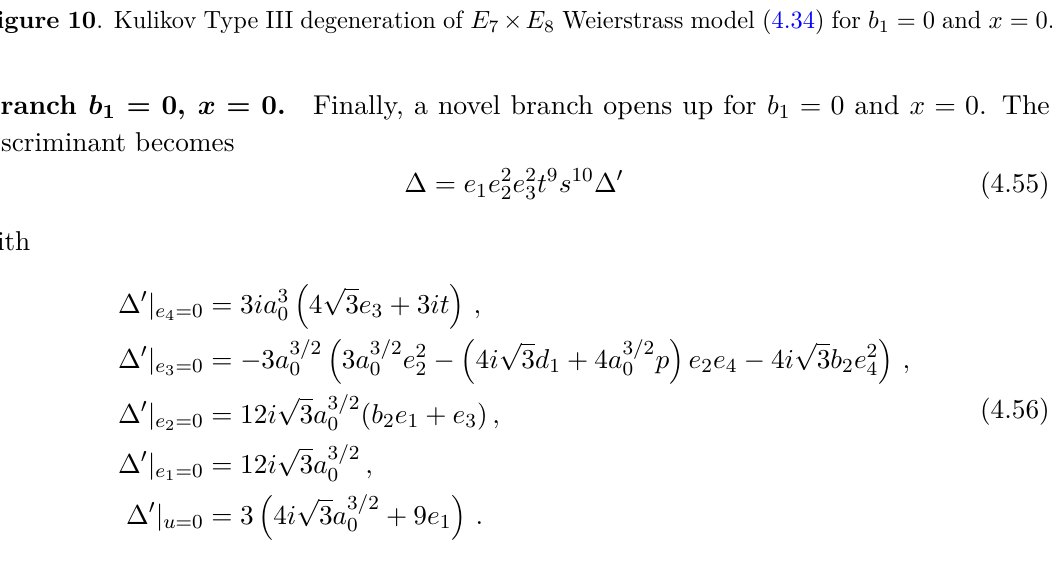
Figure 10 . Kulikov Type III degeneration of E 7 × E 8 Weierstrass model (4.34) for b 1 = 0 and x = 0 .